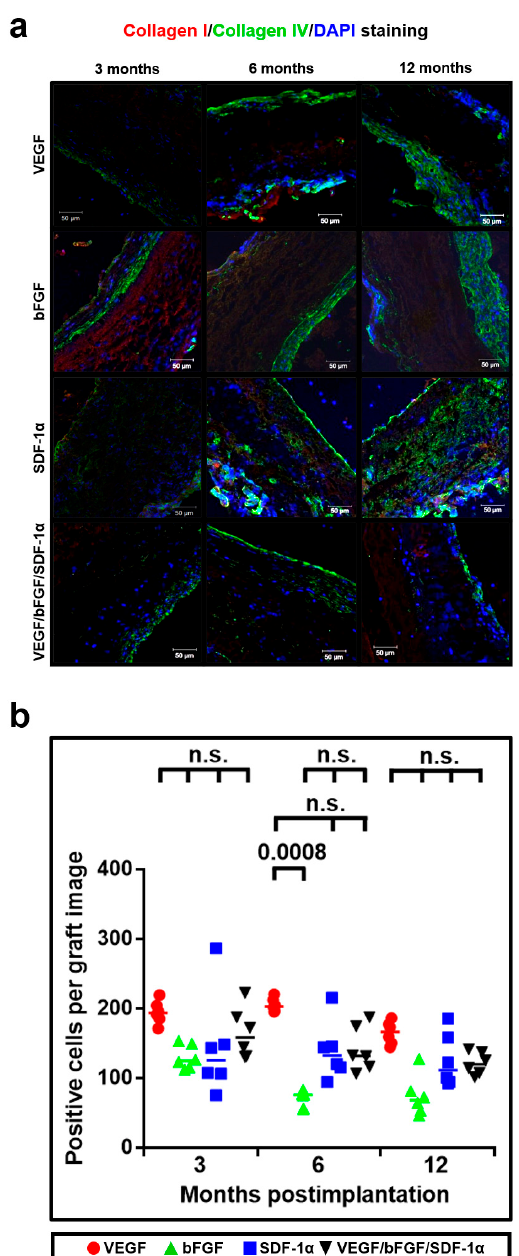
Figure 6. Either bFGF or SDF-1 α do not change the number of collagen-producing cells within the grafts. ( a ) Representative images of collagen I- (red), collagen IV- (green), and DAPI- (blue) stained grafts modified with either VEGF, bFGF, SDF-1 α , or all three factors at 3, 6, and 12 months postimplantation; ( b ) Quantitative image analysis, data are represented as a univariate scatterplot with the median, each dot represents a count from one image, Kruskal–Wallis test with the further Dunn’s multiple comparisons test, p values adjusted for multiple comparisons are reported in a numerical manner, n.s. is for not significant. 2.6. bFGF and SDF-1 α Support VEGF-Induced Endothelialization of the Luminal Surface Further, we hypothesized that either bFGF or SDF-1 α can recruit specific cell populations or increase their viability instead of raising total number of functional cells.